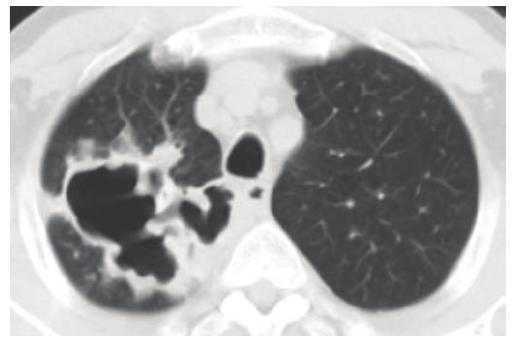
Figure 2: Computed tomography of the chest at presentation.